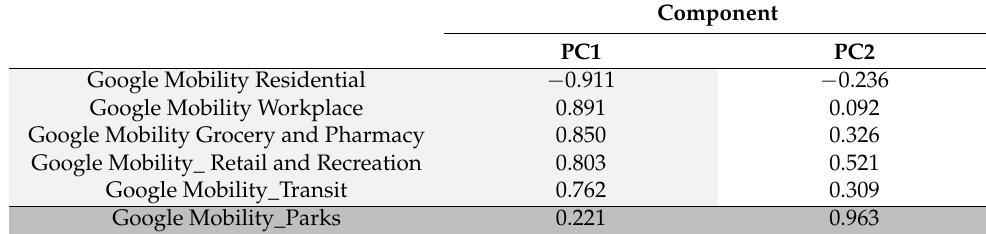
Figure 10. Monthly linear regression for overnights.